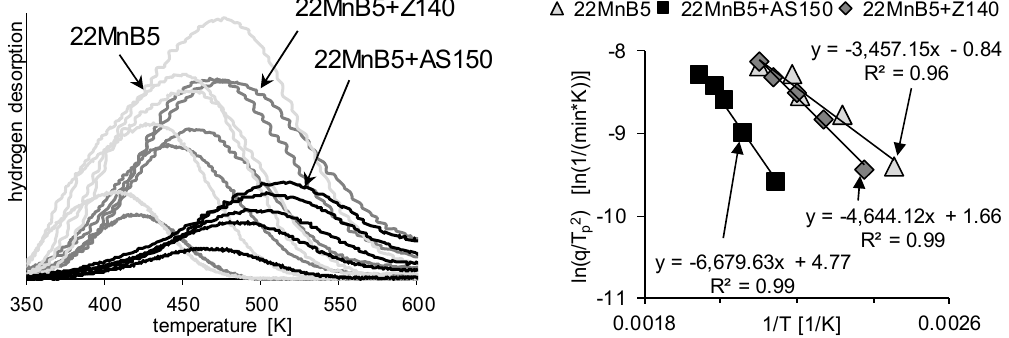
Figure 14. Thermal desorption analysis on 22MnB5 sheets with different coating concepts and varying heating rates ( left ), representation of the results according to Equation (2) ( right ).